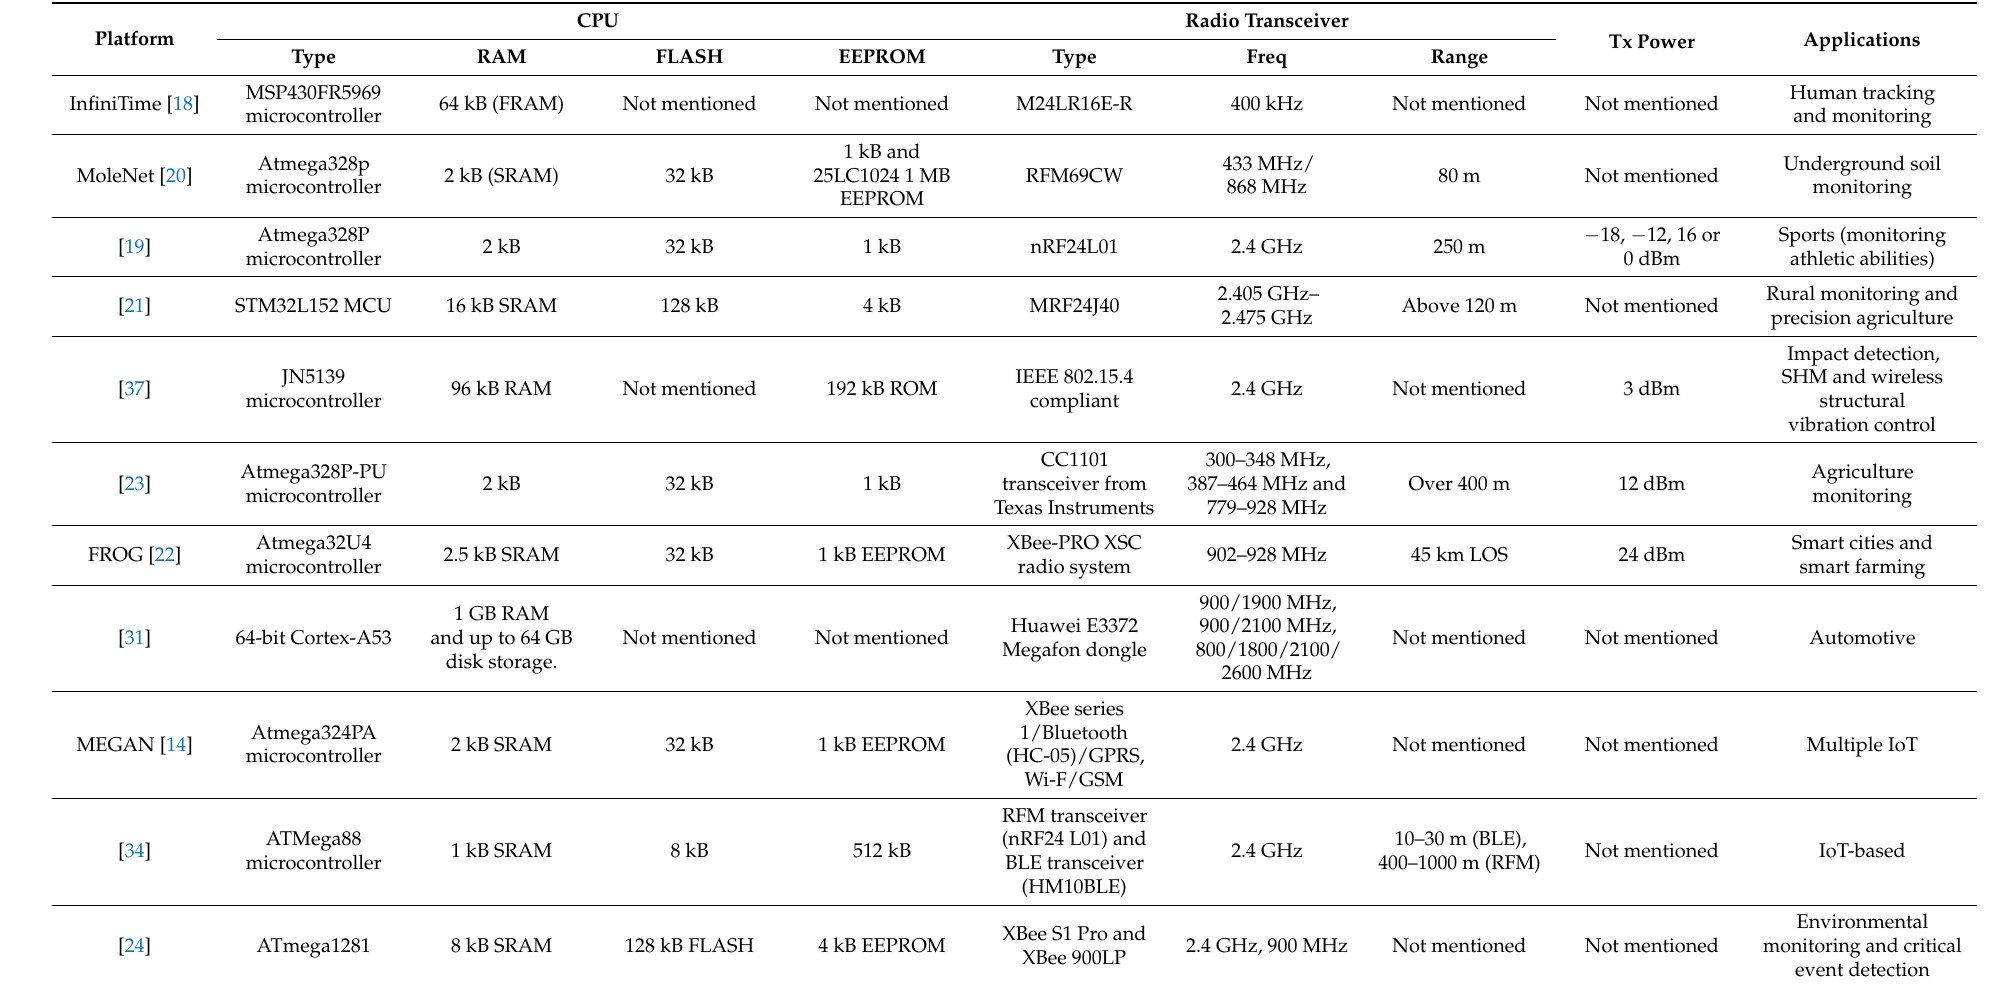
Table 1. A summary of features and applications of sensor nodes from recent research